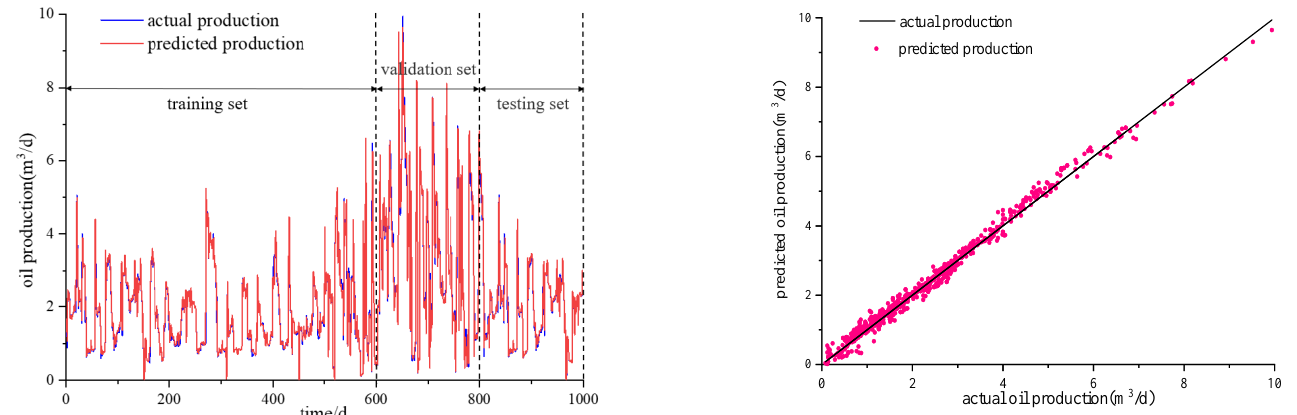
Figure 9. Comparison between actual production and predicted production by the CNN-LSTM neural network.